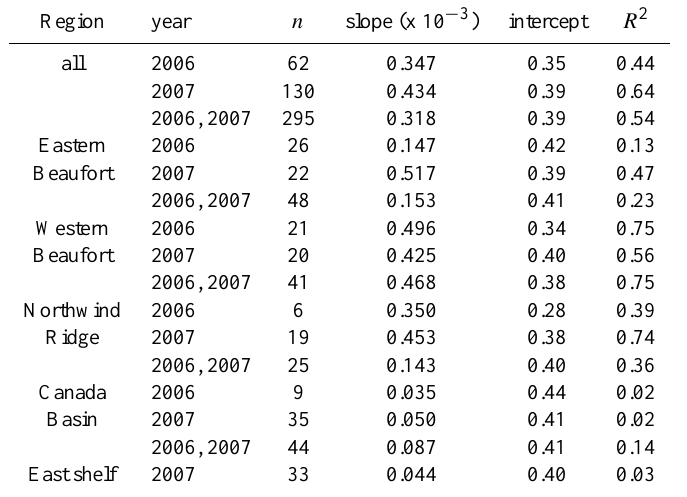
Table 1. A comparison of the relationships between beam attenuation coefficient and total suspended solids. The symbol n represents the number of samples in each linear regression. The units for slope and intercept are m − 1 (µgkg − 1 ) − 1 and m − 1 , respectively.